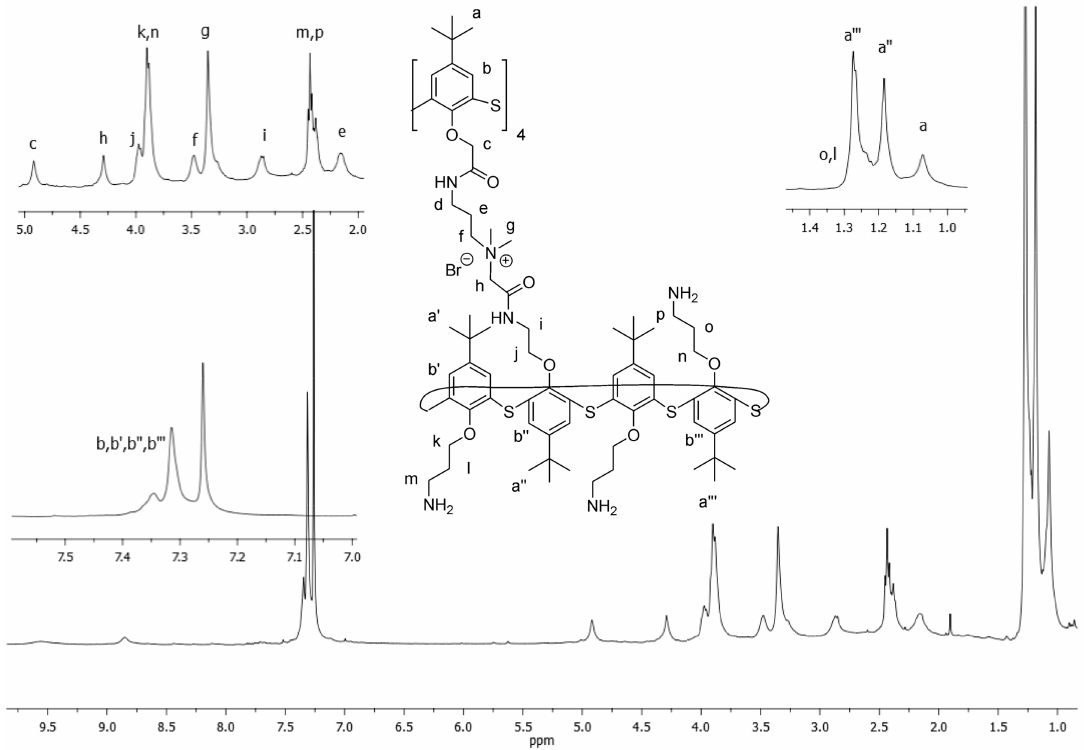
Figure 3. 1 H NMR spectrum of multithiacalix[4]arene 7